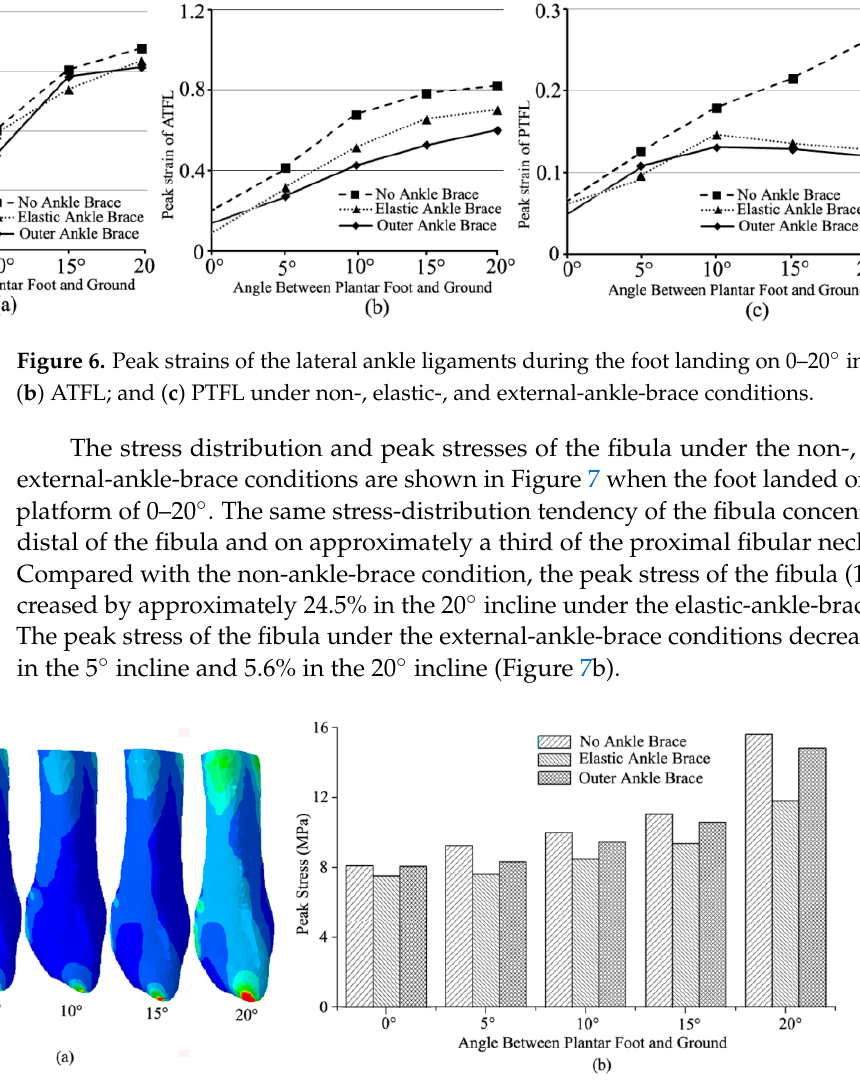
Figure 5. Peak stresses of the lateral ankle ligaments during the foot landing on 0° − 20° incline: ( a ) CFL; ( b ) ATFL; and ( c ) PTFL under non-, elastic-, and external- ankle-brace conditions.